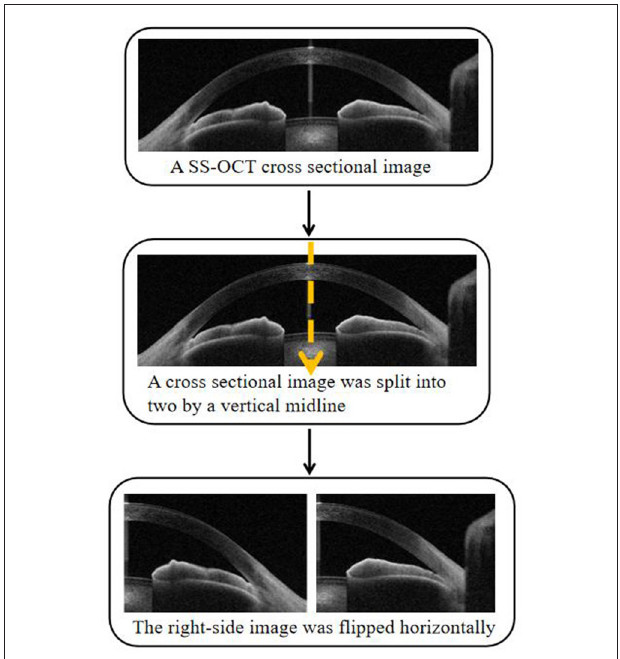
FIGURE 1 | Each swept source optical coherence tomography (SS-OCT) cross-sectional image was split into two anterior chamber angle (ACA) images with the right-side image flipped